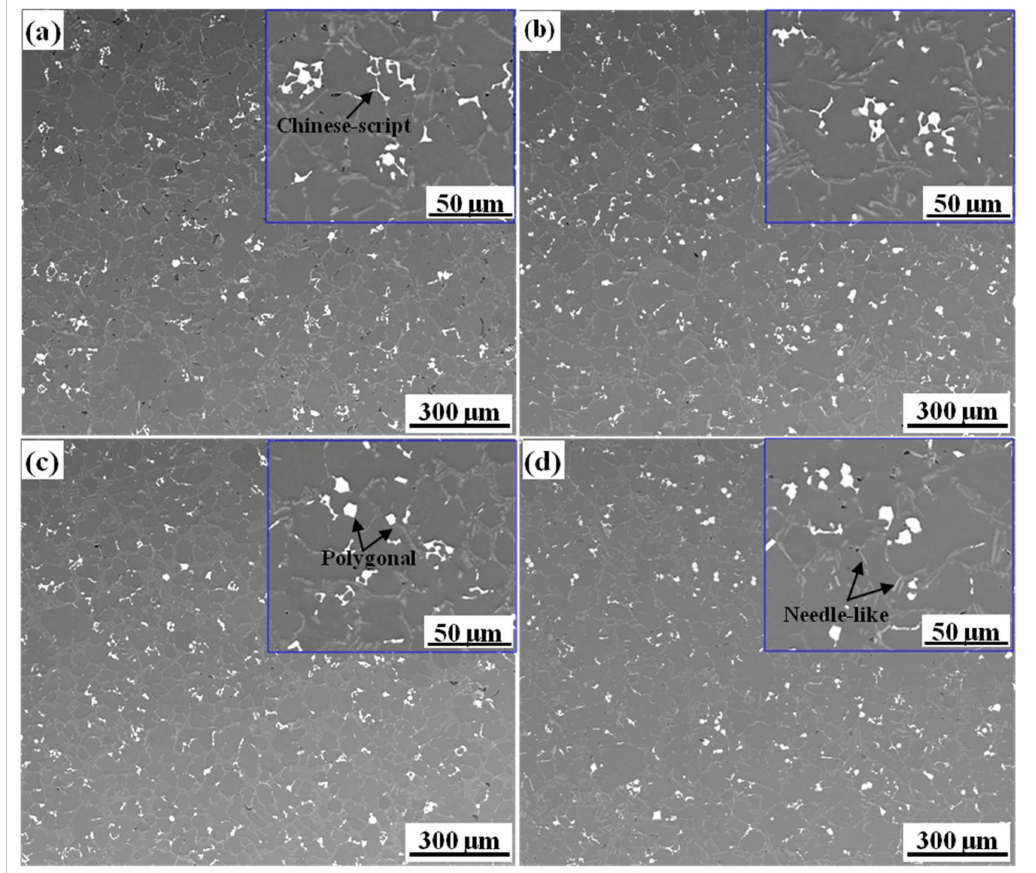
Figure 2. The morphology of the Fe-rich phase of the alloy with different initial Fe content: ( a ) 0.8%; ( b ) 1.2%; ( c ) 1.8%; ( d )